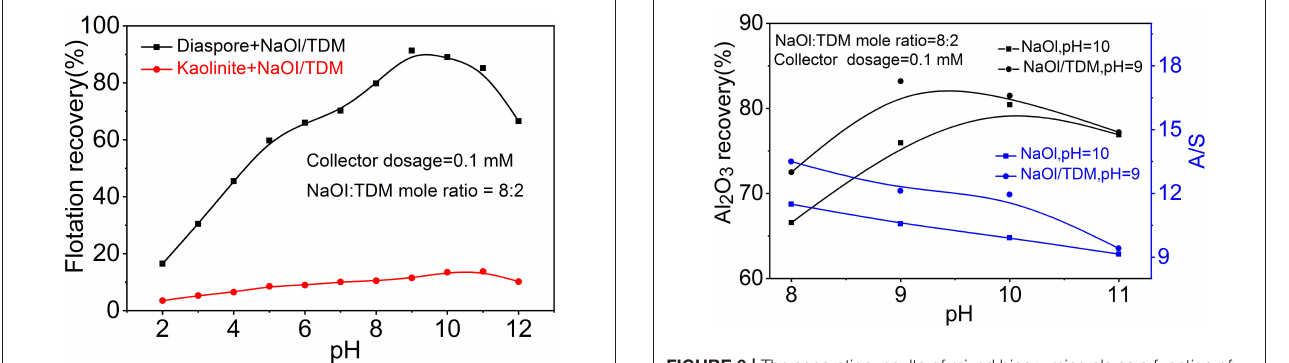
FIGURE 6 | The separation results of mixed binary minerals as a function of pH with NaOl (dosage = 0.1mM, pH = 10) or NaOl/TDM (dosage = 0.1mM, NaOl: TDM mole ratio = 8:2, pH = 9) as